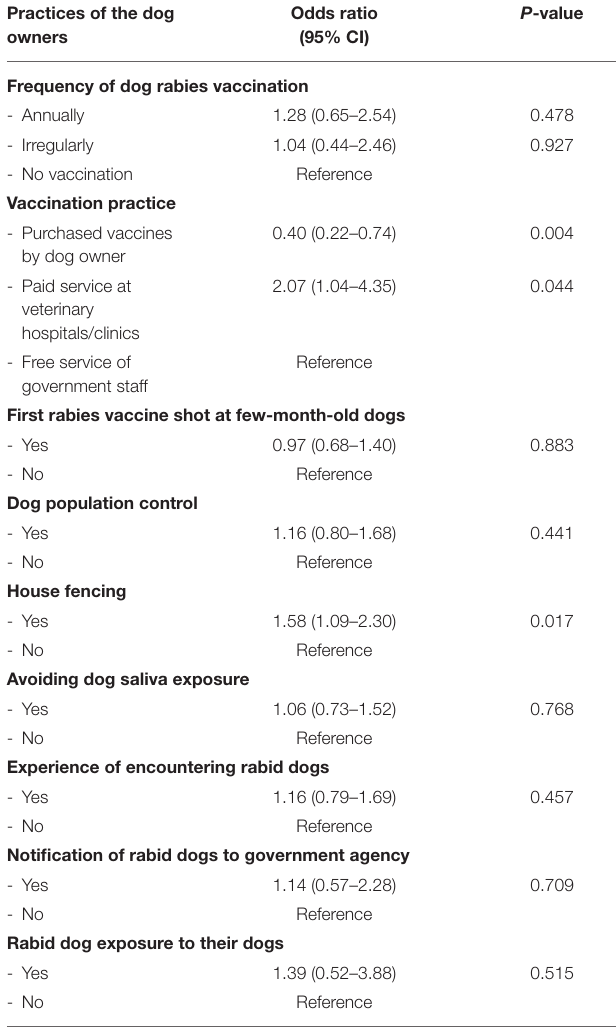
TABLE 3 | Determinants of the level of risk areas for rabies (high/low) in the univariate analysis regarding the practices of the dog owners ( n = 476).